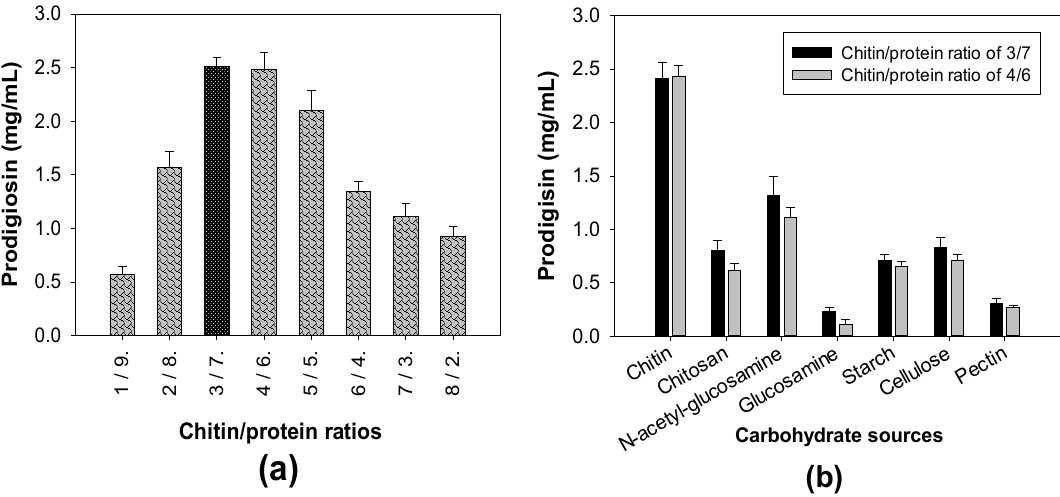
Figure 2. The influence of chitin/protein ratio ( a ) and various carbon sources ( b ) on PG biosynthesis by S. marcescens TNU01. A carbohydrate/protein ratio of 3/7 or 4/6 was used for fermentation.